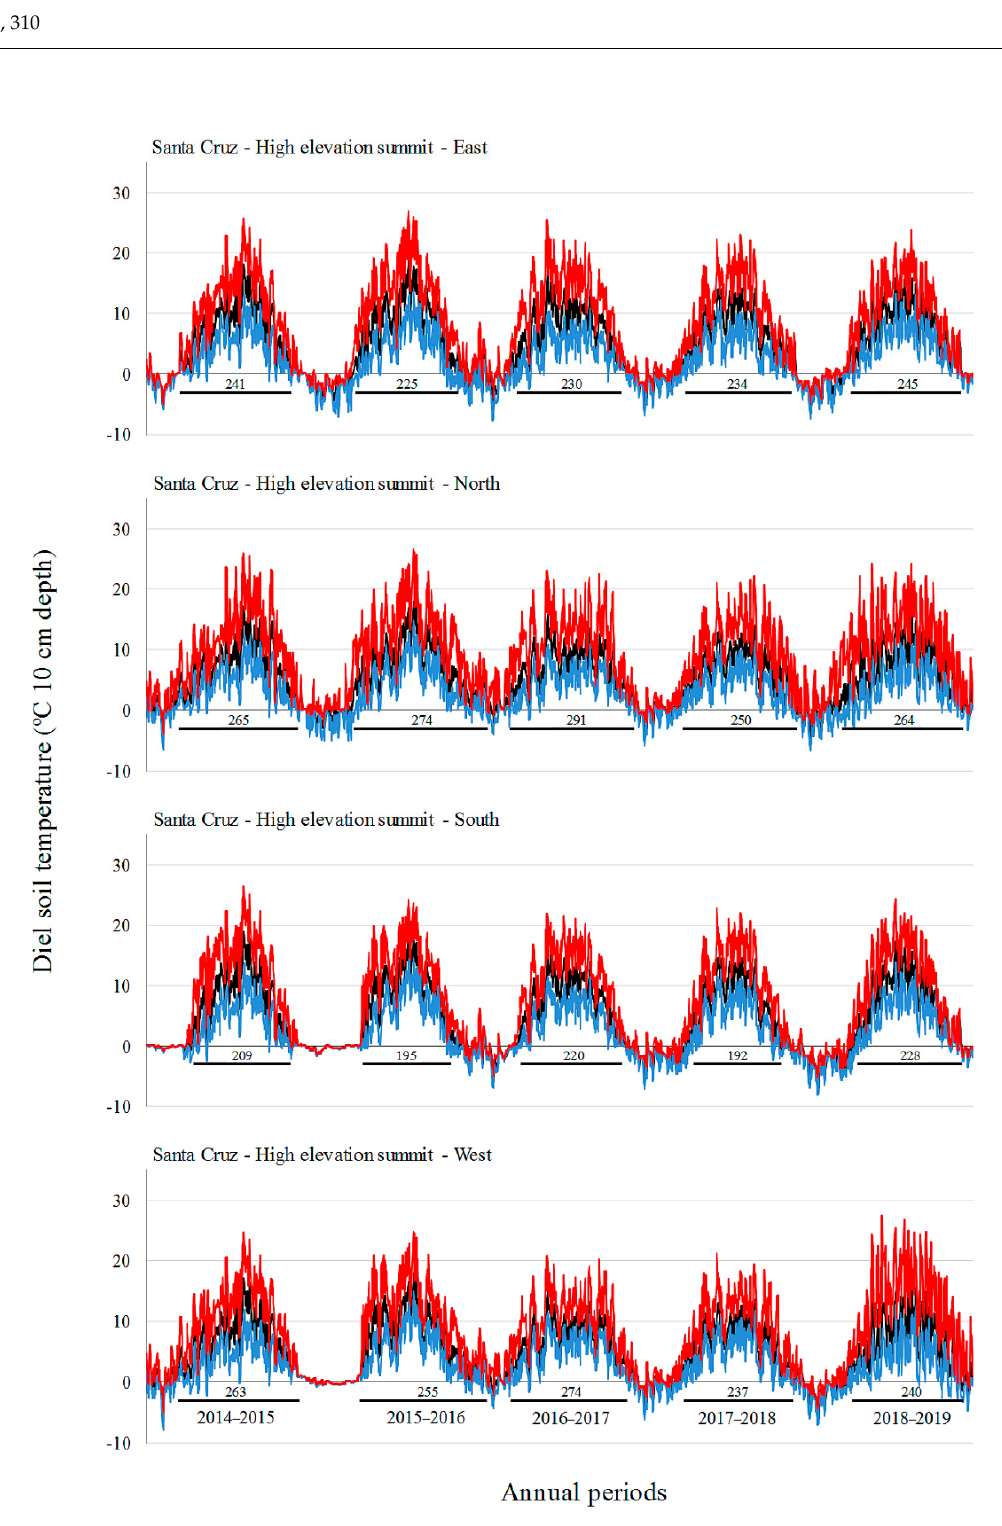
Figure A3. Diel soil temperature ( ◦ C) variation at 10 cm depth during the five studied annual periods (2014–2015 to 2018–2019) on high elevation summit in Santa Cruz, showing separately different cardinal aspects (east, north, south, west). The length of the growing season is also indicated with horizontal black bars (numbers represent days). Black = mean temperature; blue = minimum temperature, and red = maximum temperature.